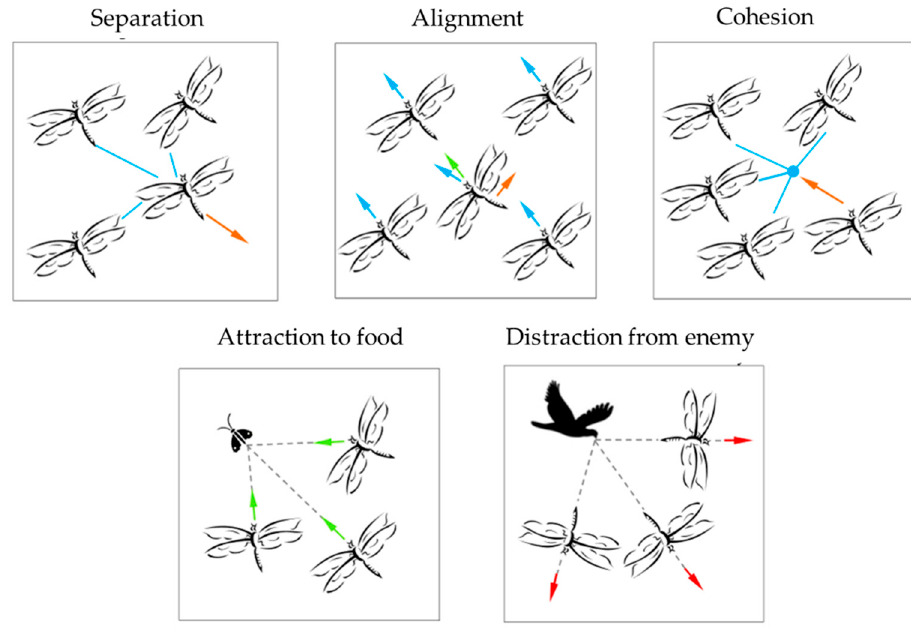
Figure 1. Five main strategies by which dragonflies change their position [8].